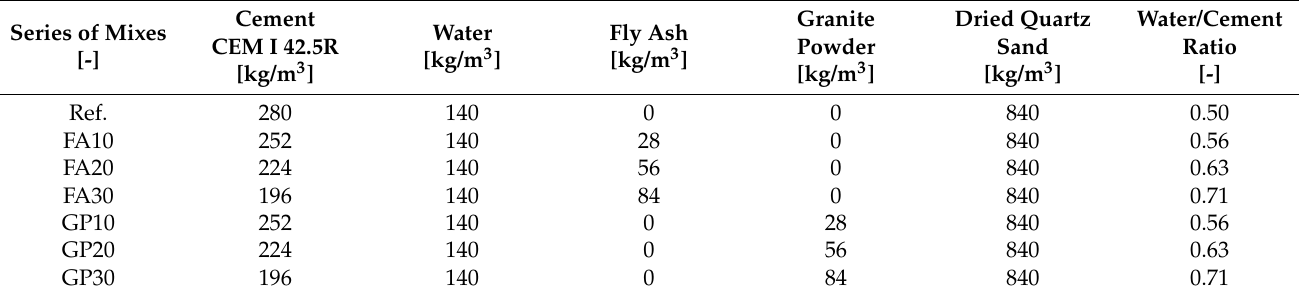
Table 1. Mix design proportions of the